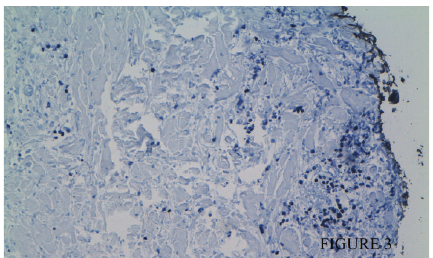
Figure 3: Dermis cell with Epstein-Barr virus- (EBV-) encoded RNA